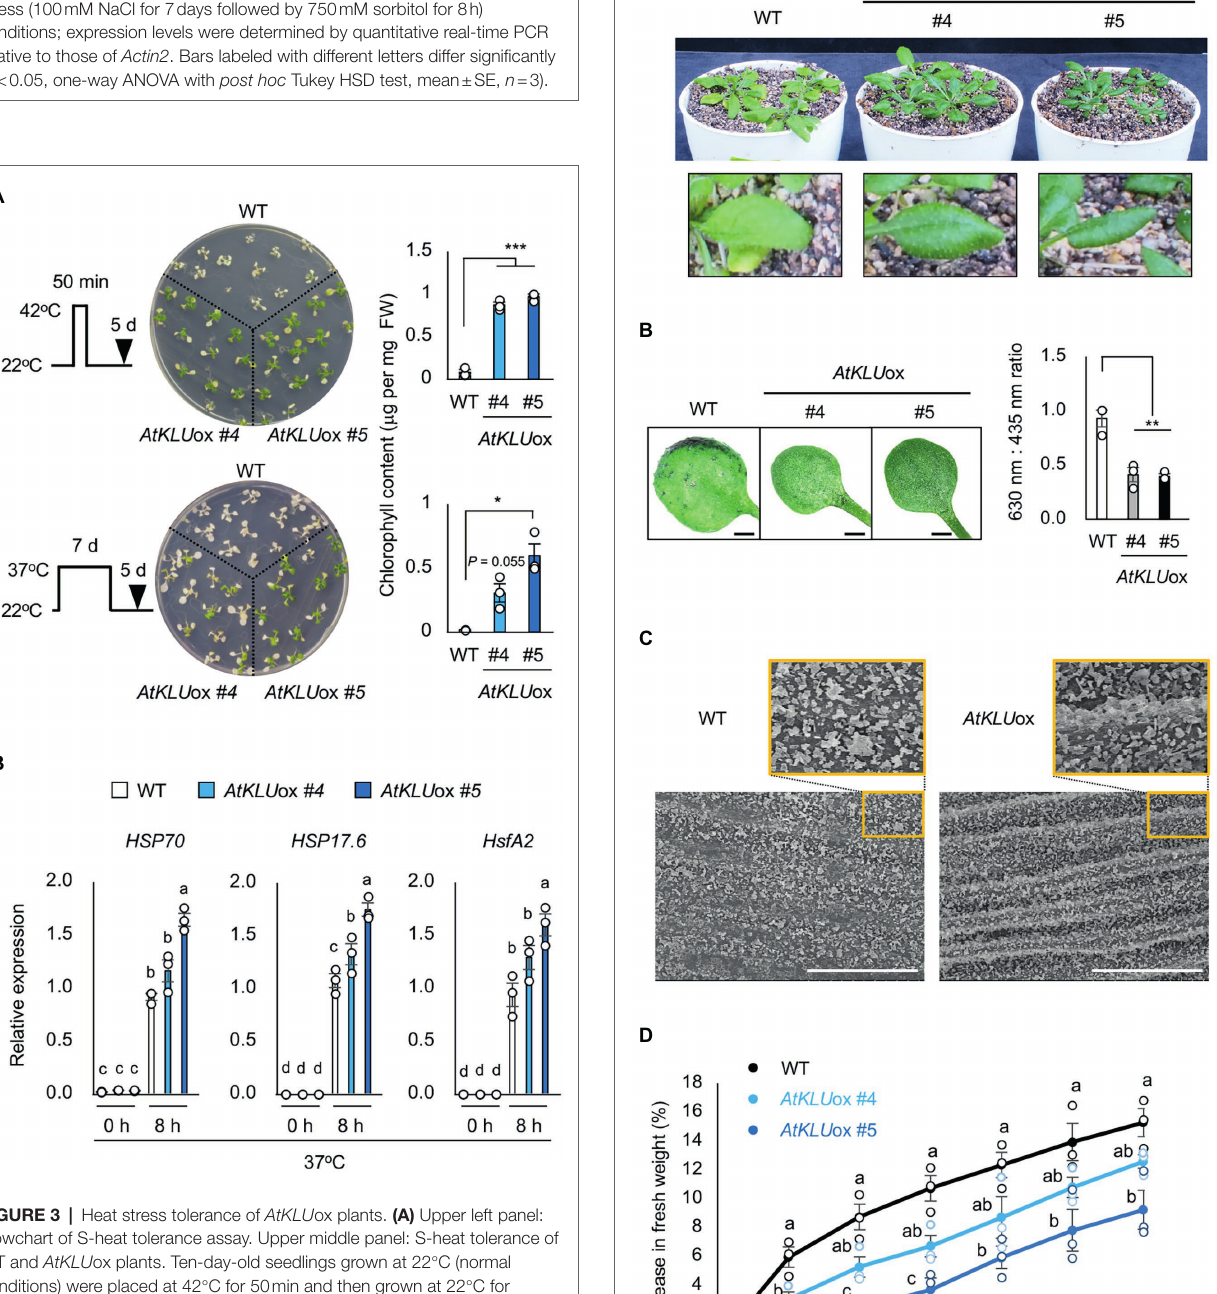
FIGURE 3 | Heat stress tolerance of AtKLU ox plants. (A) Upper left panel: Flowchart of S-heat tolerance assay. Upper middle panel: S-heat tolerance of WT and AtKLU ox plants. Ten-day-old seedlings grown at 22 ° C (normal conditions) were placed at 42 ° C for 50 min and then grown at 22 ° C for 5 days. Upper right panel: Chlorophyll content of seedlings shown at left. Lower left panel: Flow of L-heat tolerance assay. Lower middle panel: 10-day- old WT and AtKLU ox seedlings grown at 22 ° C were placed at 37 ° C for 5 days and then grown at 22 ° C for 5 days. Lower right panel: Chlorophyll content of seedlings shown in left. Differences between WT and AtKLU ox plants were analyzed by Student’s t -test (mean ± SE, n = 3, * P < 0.05, *** P < 0.001). (B) Expression of HSP70 , HSP17.6 , and HsfA2 in WT and AtKLU ox plants under normal (0 h) and heat stress (37 ° C for 8 h) conditions; expression levels were determined by quantitative real-time PCR relative to those of Actin2 . Bars labeled with different letters differ significantly ( P < 0.05, one-way ANOVA with post hoc Tukey HSD test, mean ± SE, n = 3).